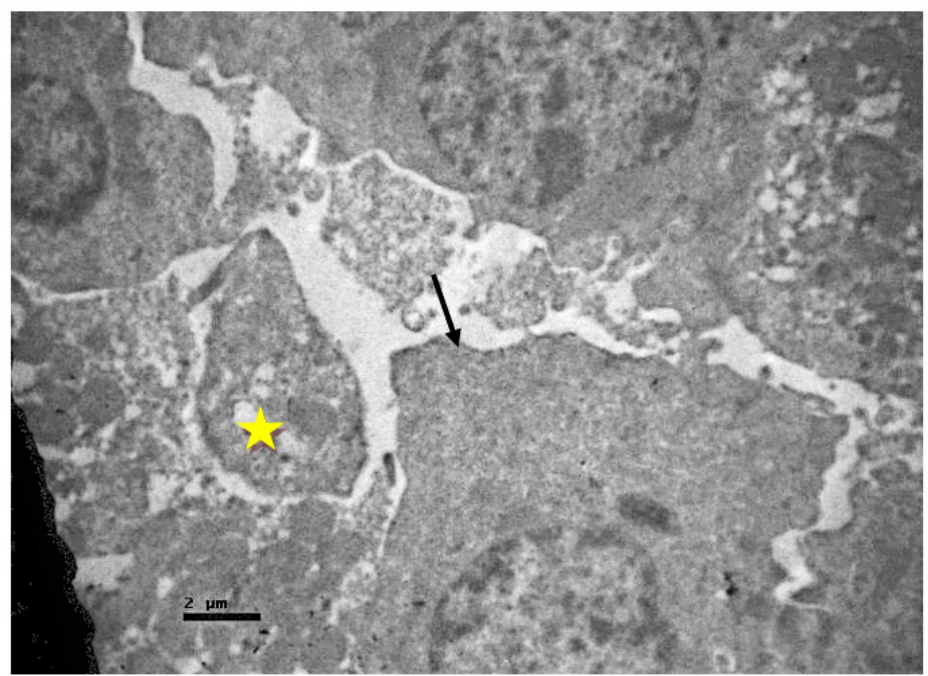
Figure 8. Cuboidal epithelial cells of proximal convoluted tubules of resuscitated swine sample. The cells appear signs of apoptosis (yellow star) and loss of surface microvilli (black arrow).